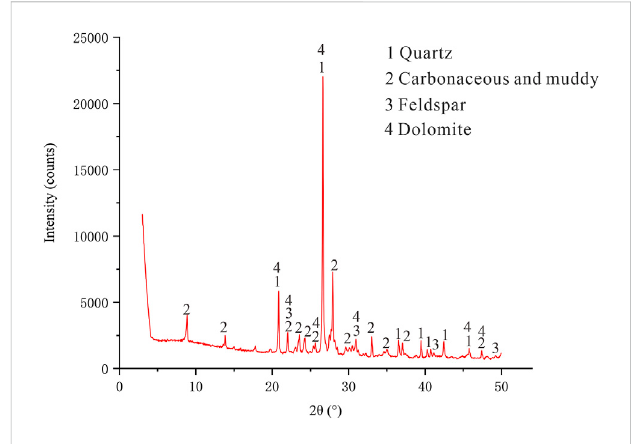
FIGURE 1 XRD whole rock diffraction analysis